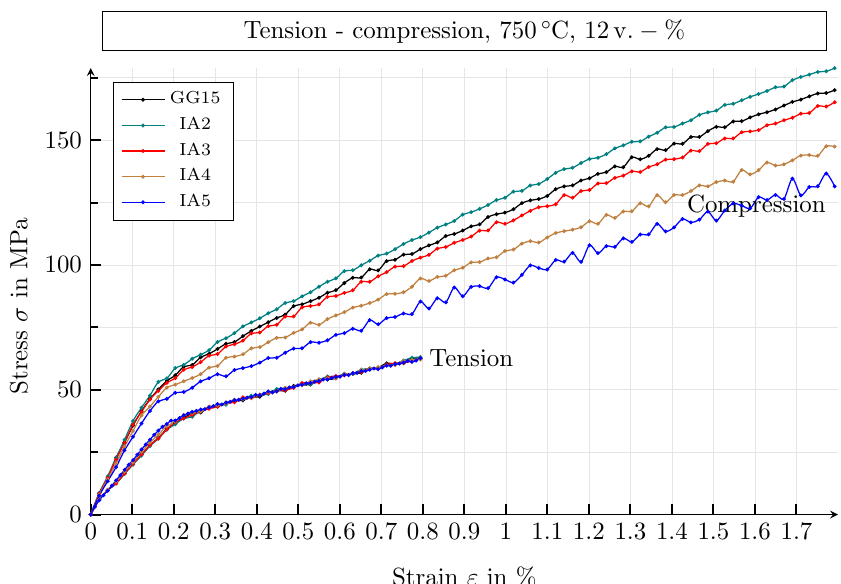
Figure 17. Stress–strain curves for tensile and compressive load of all graphite classes with 12v. of graphite precipitations and for θ = 750°C. For a clearer representation, the stress–strain curves of the compressive simulations are given by positive